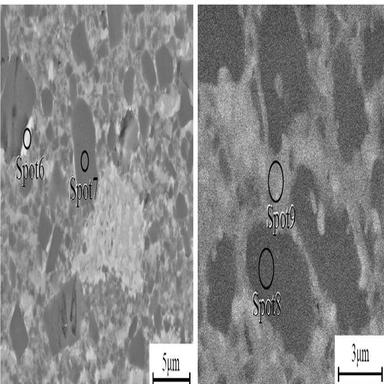
SEI images TiCXN1-X-TiCrNbMoTa composites for EDS spot analysis (a) X = 0 (b) X = 0.5 (c) X = 0.7 (d) X = 1.0.